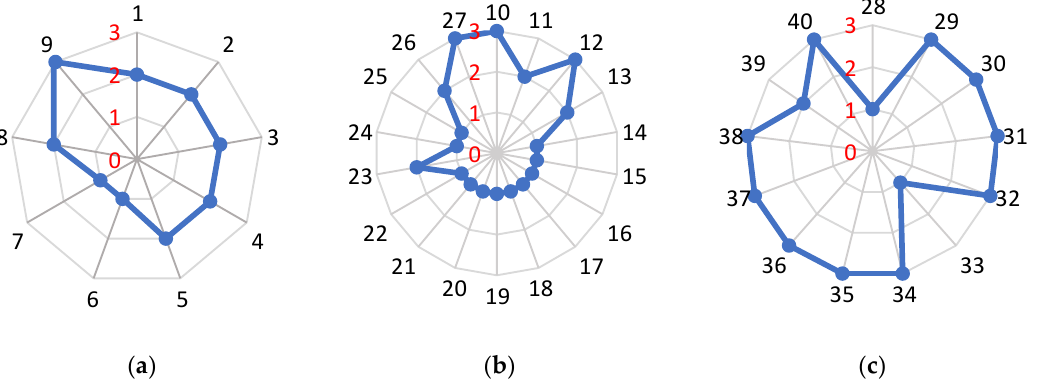
Figure 2. The radar charts for opportunities, motivations, and control measures. Notes: (a), (b), and (c) present the overall vulnerability of the opportunities, motivations, and control measures, respectively; The black numbers represent the 40 fraud factors; The red numbers represent the vulnerability level.